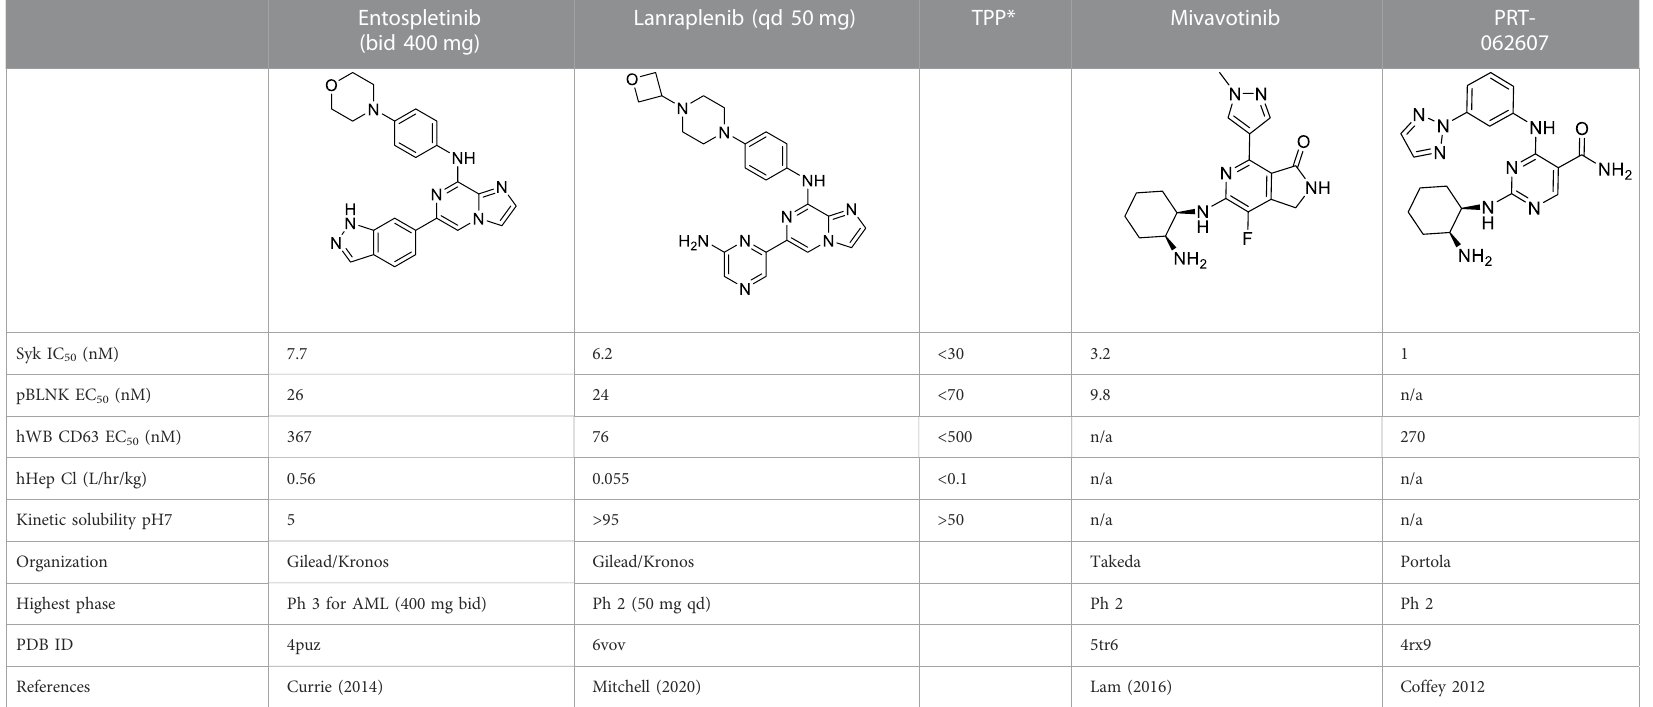
*Target product pro fi